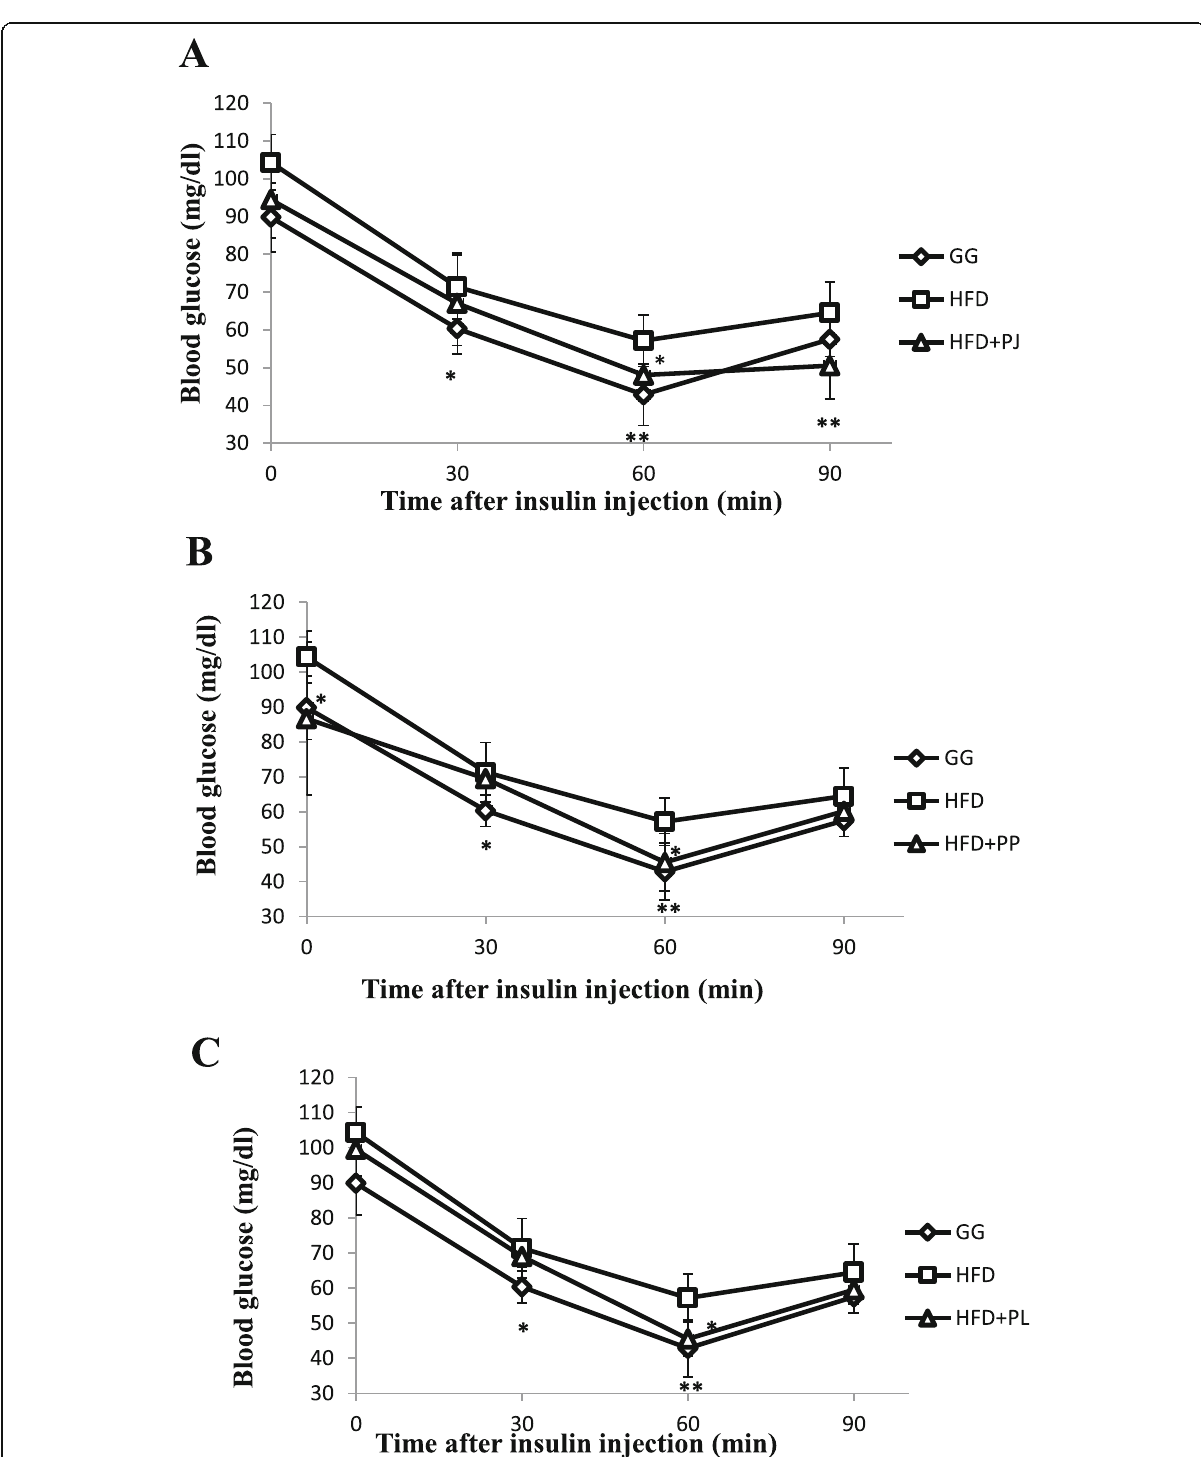
Fig. 2 Effect of pomegranate extracts supplementation on the insulin tolerance curve in rats during 11 weeks experimental period. Results are shown as the mean ± SE ( n = 6). * p < 0.05; ** p < 0.01 versus HFD group, pomegranate juice ( a ), pomegranate peel ( b ) and pomegranate leaves ( c